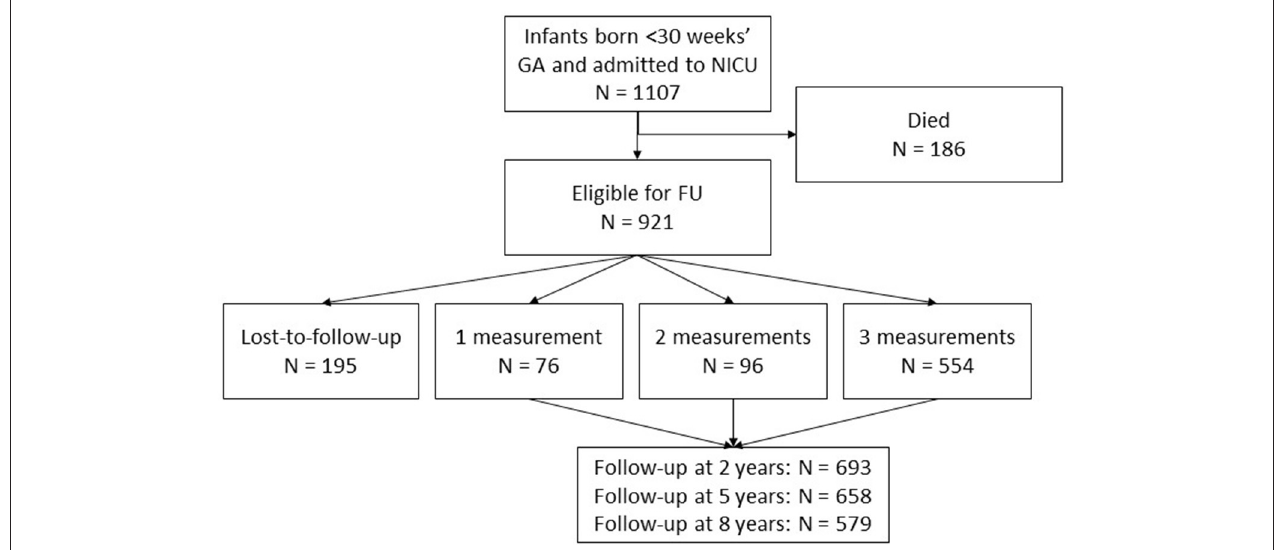
FIGURE 1 | Flowchart of the included children. 921 children were eligible for follow-up at the outpatient clinic. In total, the results are based on 726 participants with data on 1930 follow-up moments, as presented in the gray square.